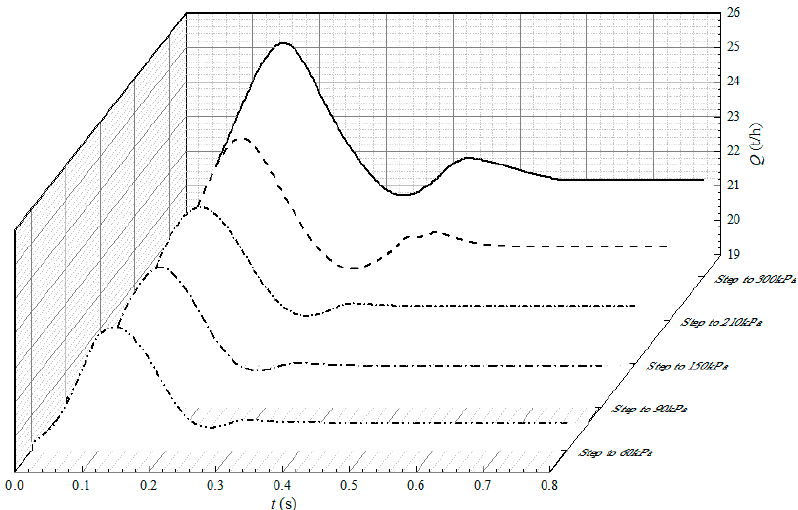
Figure 10. Flow dynamic characteristic curve under different pressure drops.